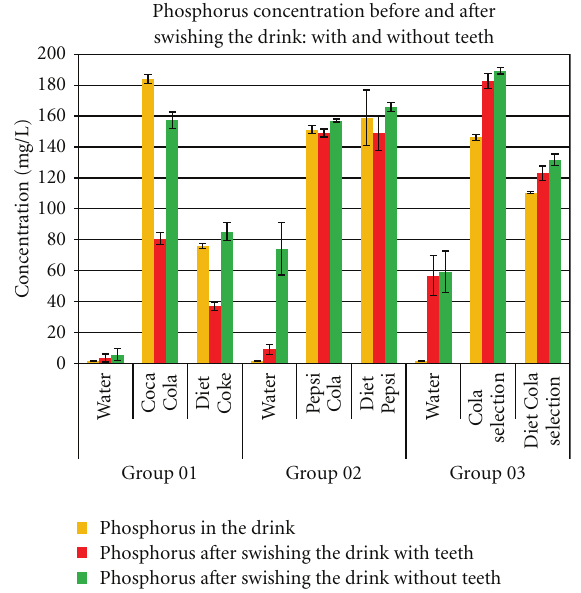
Figure 4: Phosphorous concentrations were expressed as mg/L from the source (bottled water or can) and swished test drinks. Aquafina water was used as control for all groups. Measures were assessed using ICP-OES. The phosphorus content of control (water) remains constant for each group, but the phosphorus content of swished water probes obtained from 3 separate cohorts (six volunteers for each group) vary. There is wide variation of phosphorous concentrations when swishes with cola from subjects with teeth are compared to swishes of cola from subjects without teeth . This is because there are variable amounts of phosphoric acid in the colas and phosphates in subjects’ saliva; some reactive calcium-binding phosphorous is in stimulated saliva.